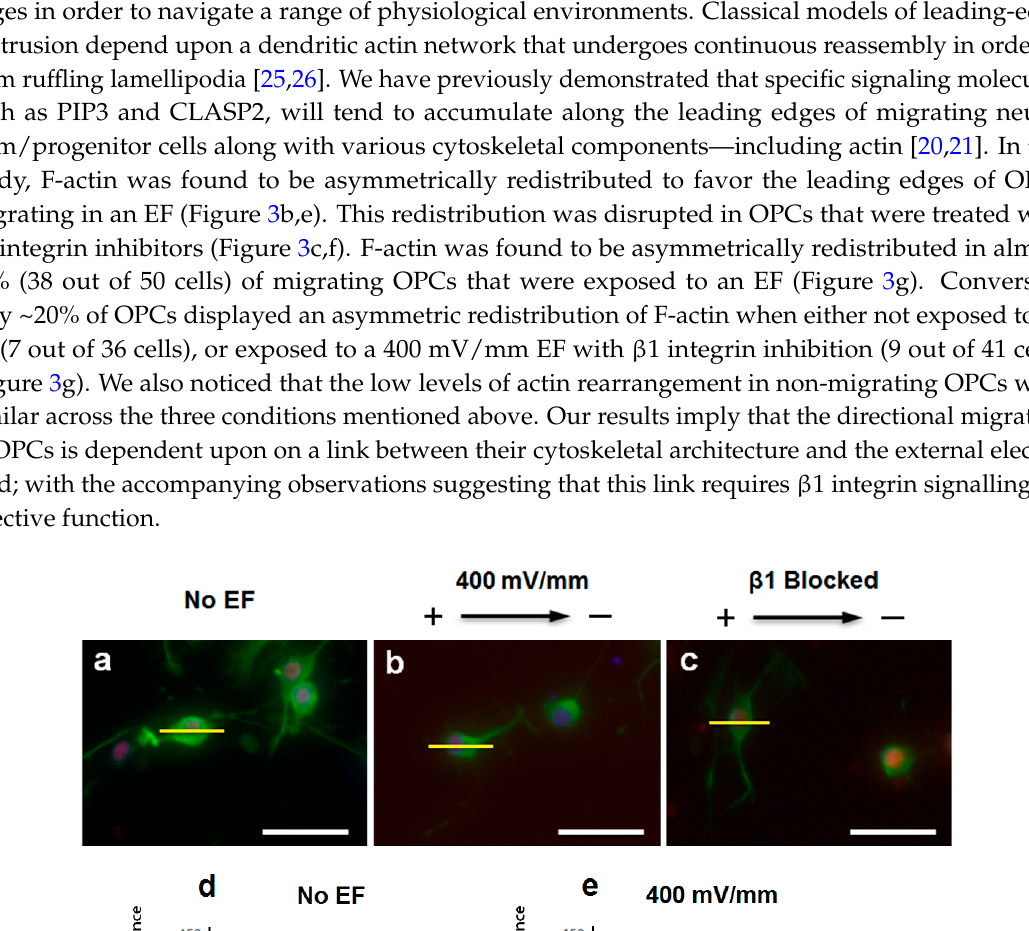
Figure 3. Asymmetric rearrangement of actin in electrotactic OPCs. Without exposure to an EF, there is no obvious asymmetric distribution of actin in OPCs ( a ); Results show an asymmetric reorganization of actin towards the leading edge of rat OPCs following exposure to a 400 mV/mm EF ( b ); Actin localization was observed to be similar in both OPCs that were not EF-treated, and OPCs that were exposed to a 400 mV/mm EF with β 1 integrin inhibition ( c ); A fluorescence intensity scan measures the average fluorescence along three lines drawn at random positions in 30 different cells. Linear fl uorescence intensity scans ( d – f ) were conducted along the yellow lines (shown as examples) in the images ( a – c ), respectively. The relative fluorescence intensities generated by ICC-stained DAPI and F-actin were analysed and compared under each experimental condition; no EF ( d ), 400 mV/mm EF ( e ) and 400 mV/mm EF with β 1 integrin inhibition ( f ); Quantification results of OPCs with asymmetric rearrangement of F-actin to the leading edge of migrating cells ( g ). Statistical analysis (by χ 2 -test) indicates that the observed differences in asymmetric F-actin distribution between OPCs from the EF group, and OPCs from the groups No EF and EF with β 1 inhibition, are both significant (* p < 0.05). Composite images ( a – c ) are merged images consisting of 3 channels: F-actin ( green ), Olig2 ( red ), and DAPI ( blue ). Scale bar = 50 μ m.